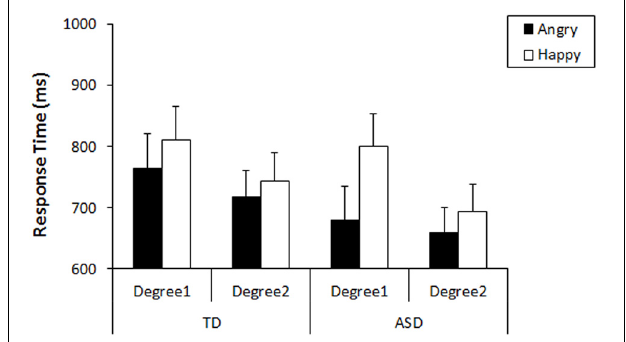
FIGURE 2 | Mean response times in the detection of angry/happy targets with each Emotion-degree in the search. Error bars: 95%